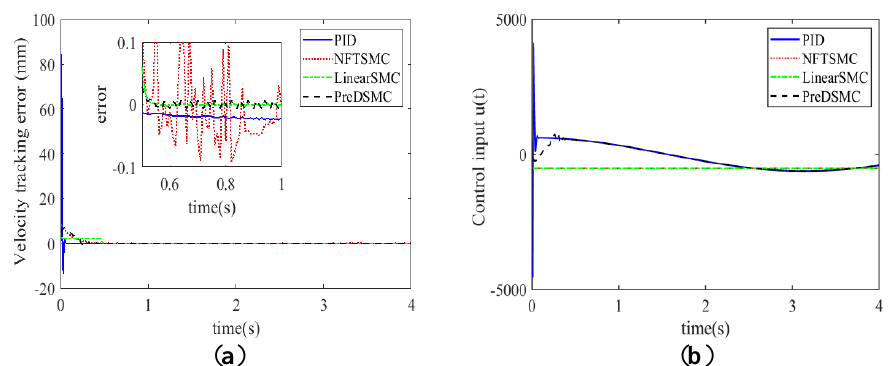
Figure 6. ( a ) Comparison of sinusoid velocity tracking error displacement for all controllers. ( b ) Control input for different control algorithms.